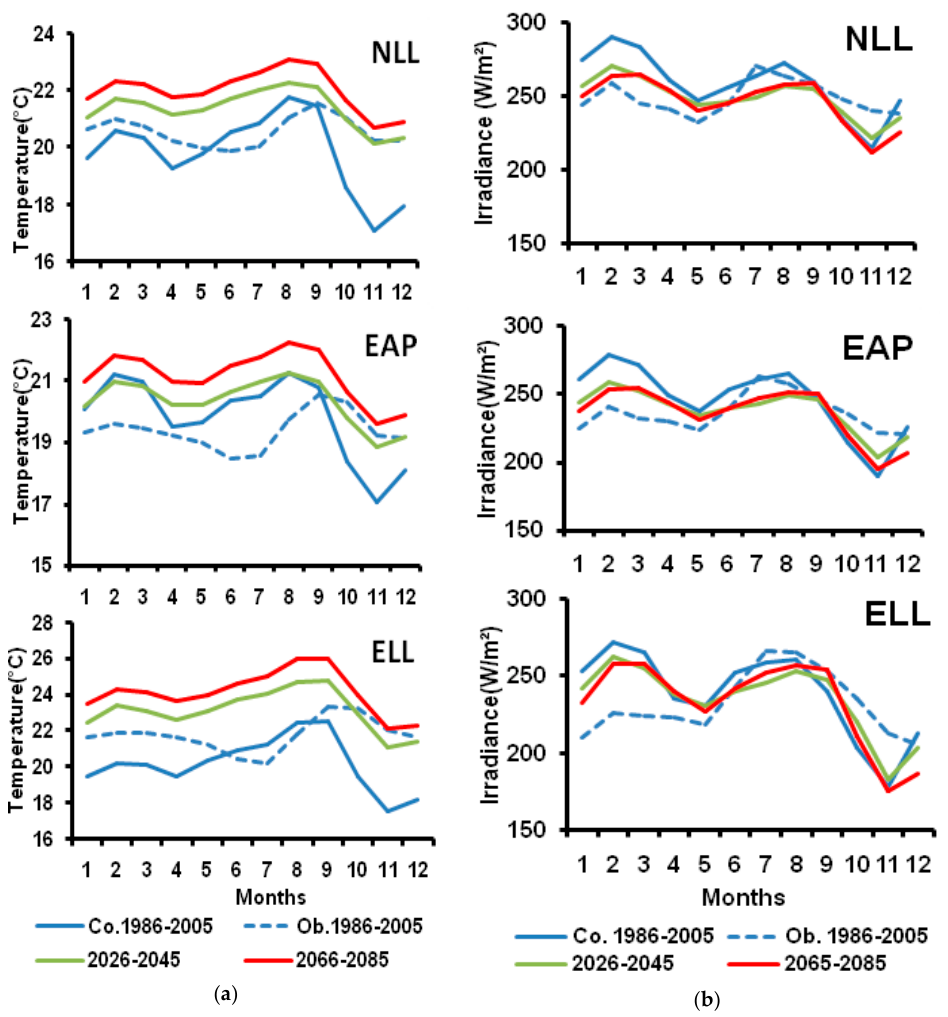
Figure 6. Historical and projected monthly mean ( a )temperature and ( b ) solar irradiance over the periods2026–2045 and 2066–2085. (Co.1986–2005*: CORDEX Data 1986–2005, Ob.1986–2005*: Observed Data 1986–2005).